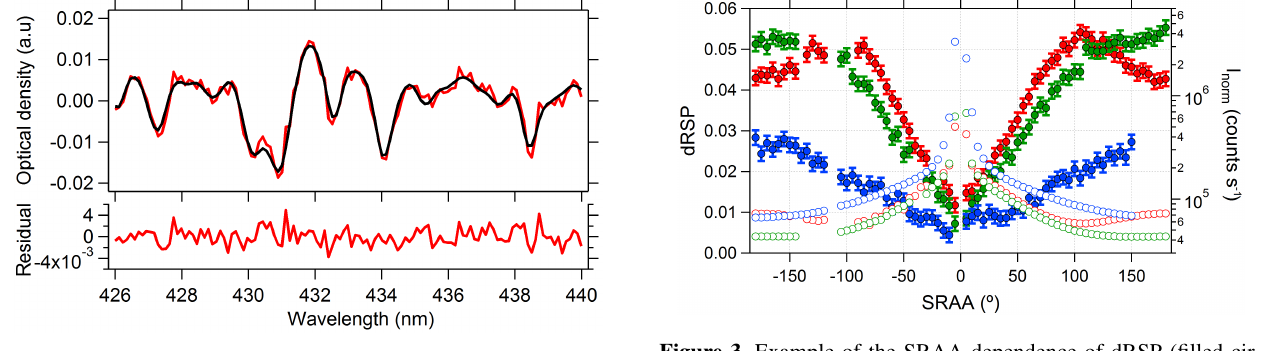
Figure 2. Top: example of spectral proof for the detection of dRSP (1s integration time) using the solar azimuth scan on 22 July 2012 at 7:43LST (SZA = 66.3 ◦ , SRAA = 120 ◦ , EA = solar EA). The red line represents the measured spectra and black line is the fitted nor- malized Ring cross section. The dRSP is 0 . 0502 ± 0 . 0011. Bot- tom: residual from the DOAS fit, RMS meas = 1 . 58 × 10 − 3 , is in good agreement with the shot-noise RMS theo = 1 . 40 × 10 − 3 based on photon counting statistics.